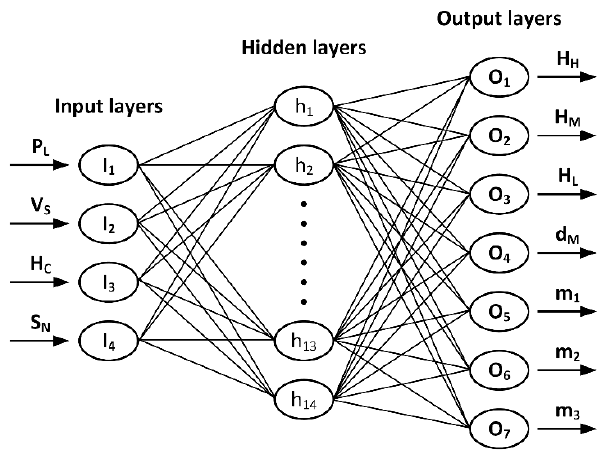
Figure 7. Punctual ANN model architecture. Coatings 2018 , 8 , x FOR PEER REVIEW